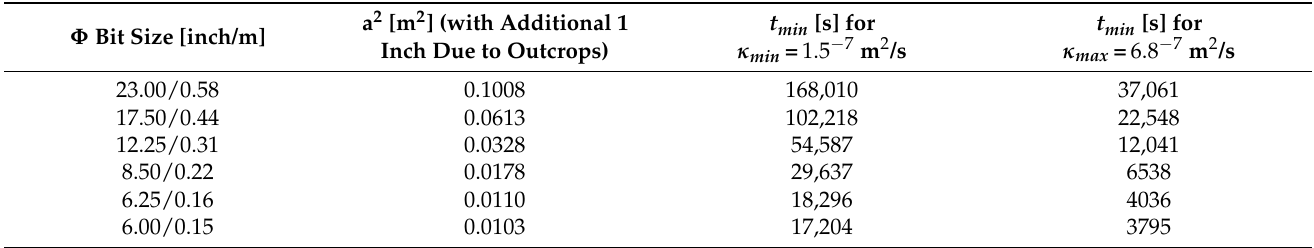
Table 3. Calculated minimum shut-in times for which the stability criterion is still met when κ is varied between 1.5 − 7 and 6.8 − 7 m 2